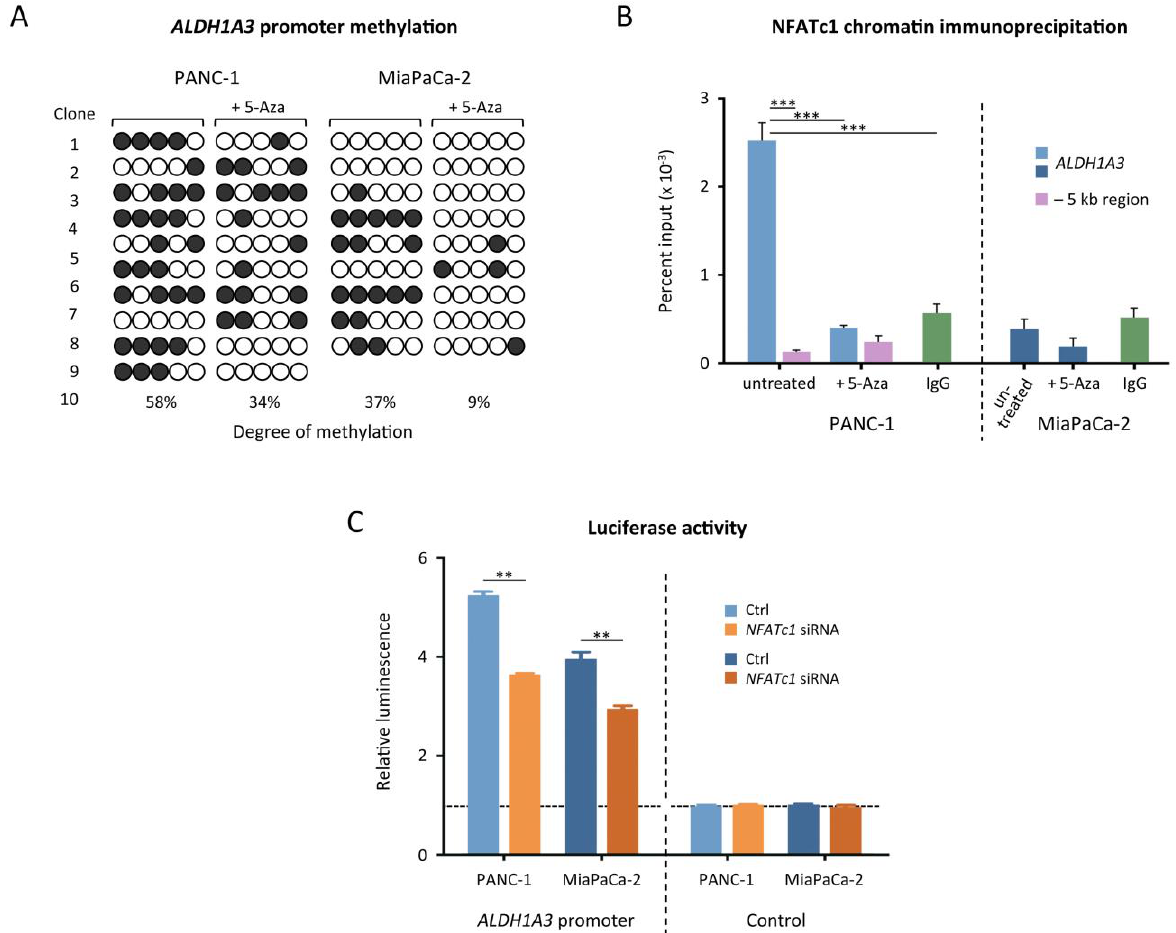
Figure 5. Methylation-mediated transcription regulation. ( A ) Bisulphite-sequencing result of the ALDH1A3 promoter ( − 1035 bp/ − 893 bp), in PANC-1 and MiaPaCa-2 before and after a treatment with 5-azacytidine (5-Aza). Each circle corresponds to a CpG site in this region, each line refers to one cloned allele. Filled circles represent methylated cytosines, empty circles stand for unmethylated cytosines. ( B ) Chromatin immunoprecipitation with antibody targeting NFATc1. The enrichment of the ALDH1A3 promoter region is shown in comparison to an arbitrarily selected genomic region located 5 kb upstream of the promoter ( − 5 kb) and results obtained with an IgG mix instead of NFATc1-specific antibody (IgG). Results after treatment with 5-Aza are also shown. ( C ) Relative luciferase activity in PANC-1 and MiaPaCa-2 cell lines. The ALDH1A3 promoter sequence was cloned into a vector construct encoding the luciferase gene. After transfection, luminescence was measured as an indicator of promoter activity. In accordance with the methylation level, higher signal was obtained in PANC-1 than MiaPaCa-2. A knockdown of NFATc1 (siRNA) also resulted in reduced signal intensities. For comparison, the empty vector was used as a control. ** = p ≤ 0.01; *** = p ≤ 0.001 .